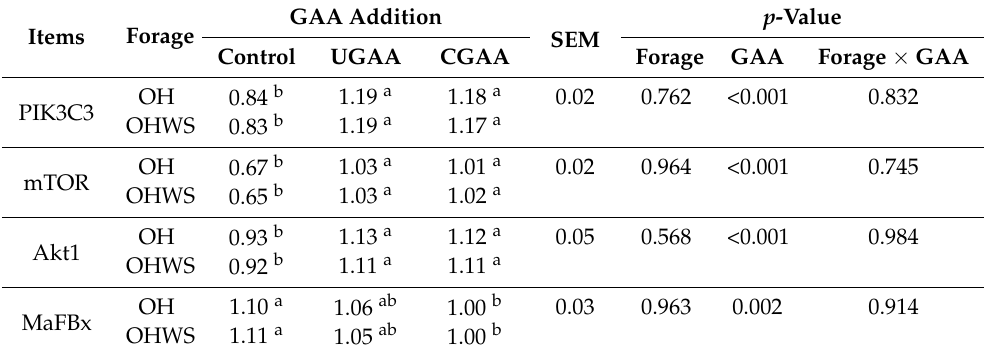
Table 8. Effects of forage type and GAA addition on gene expression in feedlotting